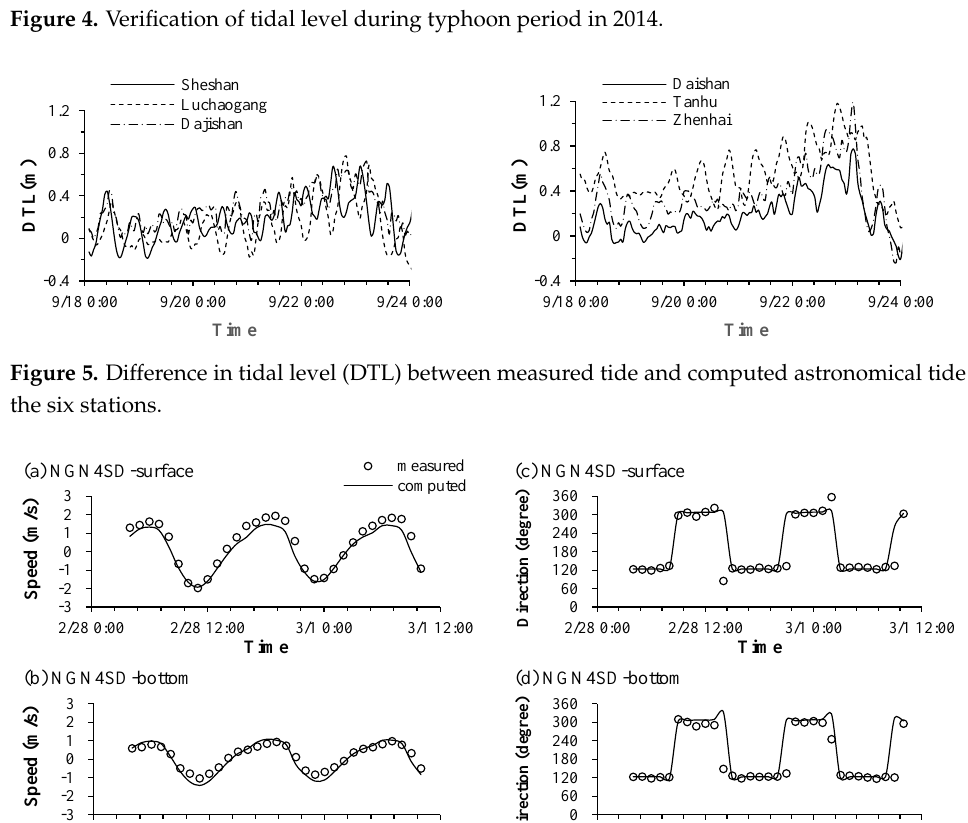
Figure 4. Verification of tidal level during typhoon period in 2014.